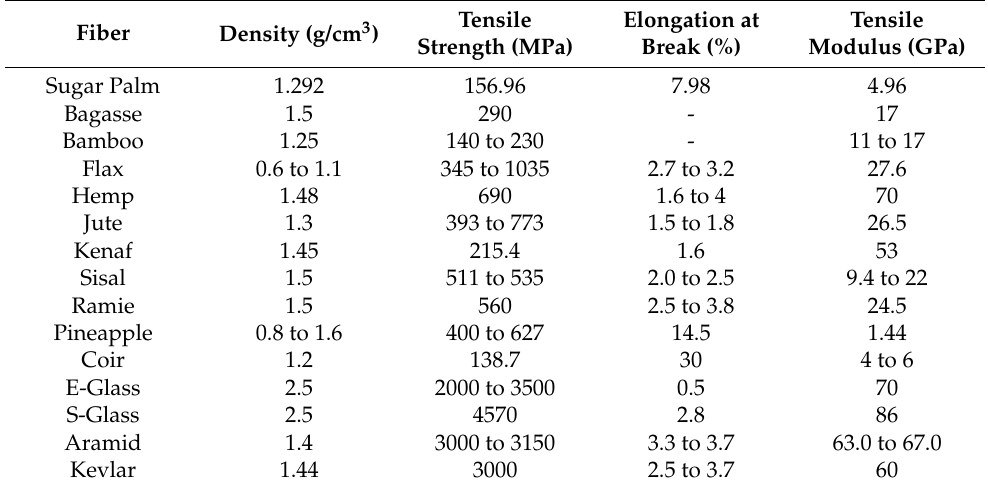
Table 2. Comparison the physical and mechanical performance of natural fiber with synthetic